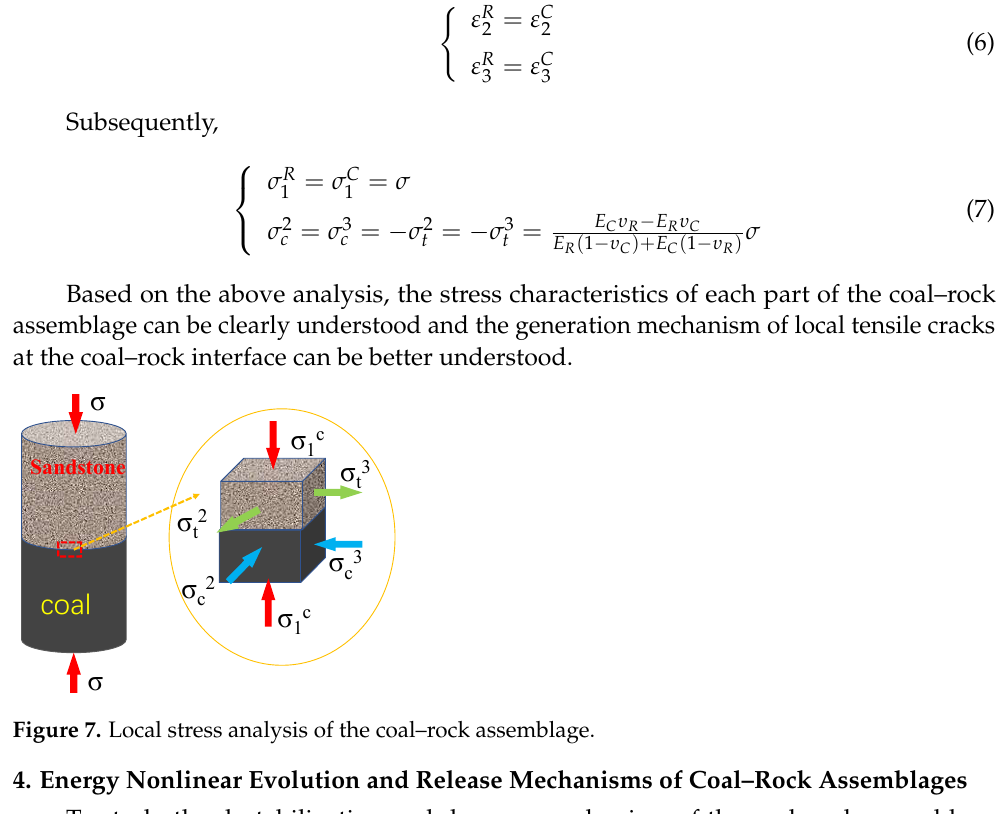
( b ) Figure 8. Deformation model of coal–rock assemblage. ( a ) C omposite coal–rock deformation dia- gram; ( b )strain test results of composite coal–rock mass. The coal and rock components constitute the coal–rock assemblage, which is kept in mechanical equilibrium under the load  . The load-displacement curves of the rock com- ponent and the coal component can be expressed by Equation (7). The strength of the rock